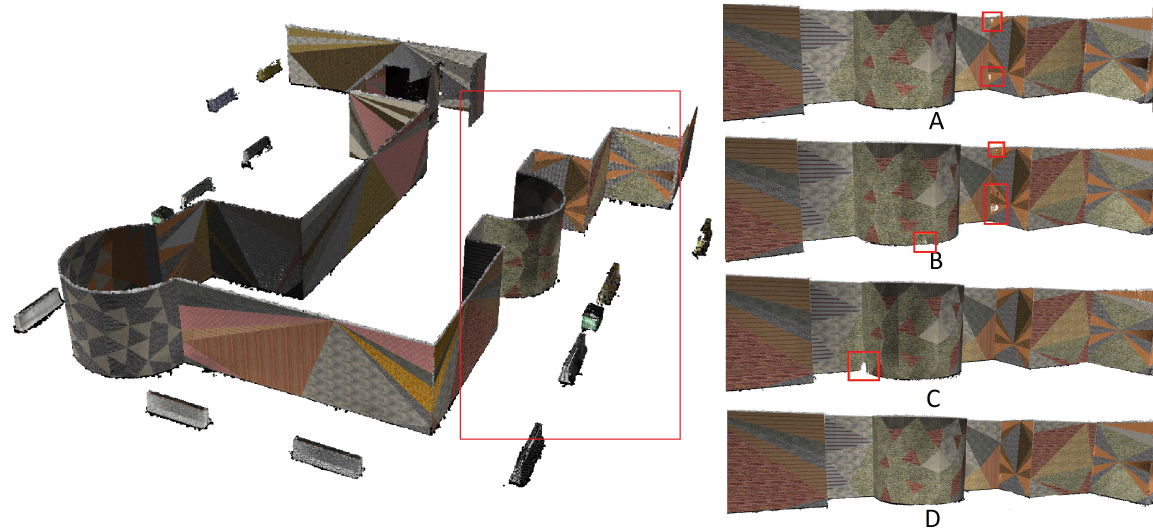
Figure 17. The final point cloud of the complex building ( left ) and the point clouds of the selected area in the red box for the centre pointing ( A ), façade pointing ( B ), hybrid ( C ) and centre & façade pointing ( D ) approaches. The gaps in the point cloud are shown using red boxes at the right of the figures.